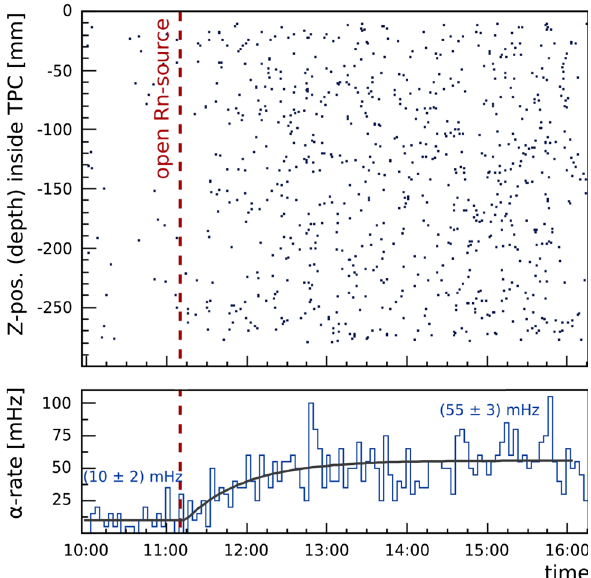
Fig. 5 Combined 222 Rn and 218 Po α -decays before and after opening the auxiliary radon emanation source. The α -rate saturates about 2h after opening the source ( bottom ). The spatial distribution of the events is homogeneous at any time ( top